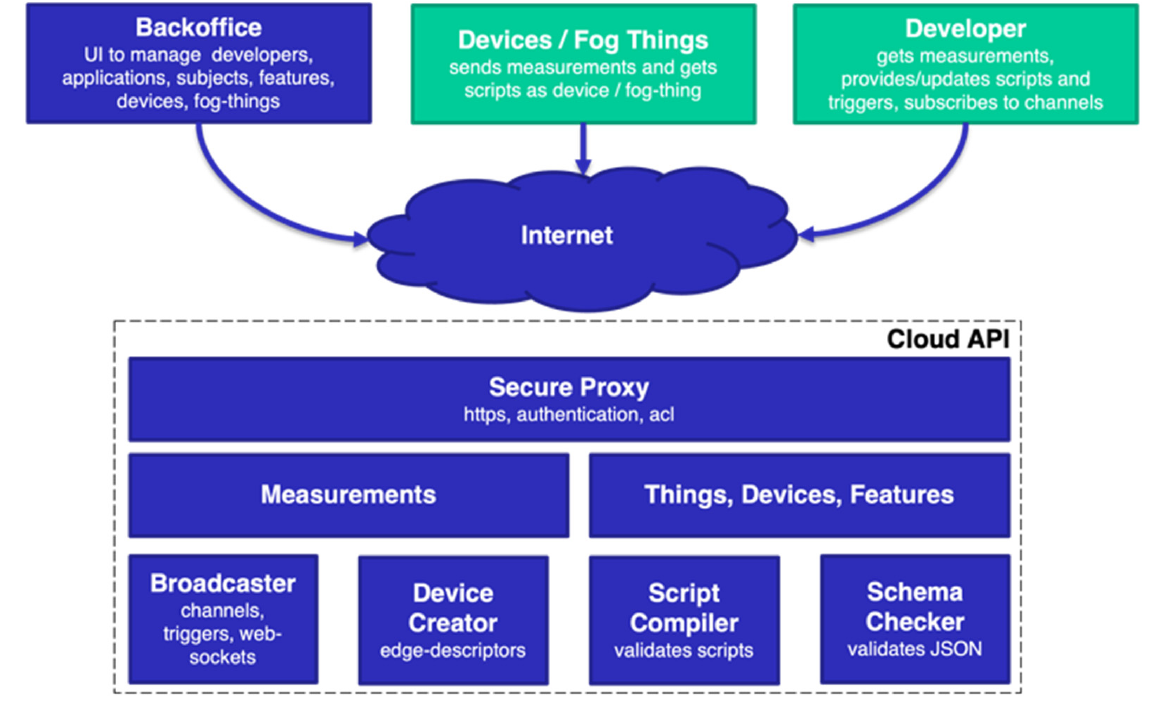
Figure 1. Measurify cloud API architecture.